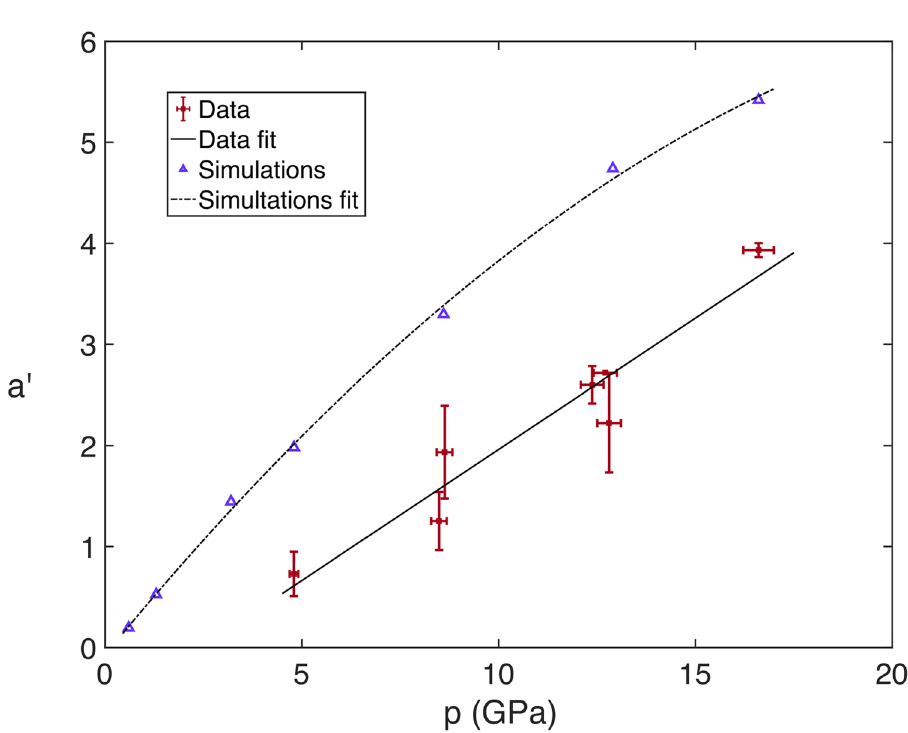
Figure 10. Plots of a ′ vs. p , with the data for the experiments with shock pressures of 4.80 GPa and above. The solid line shows the linear fit of the experimental data and the dashed line shows the quadratic fit for the